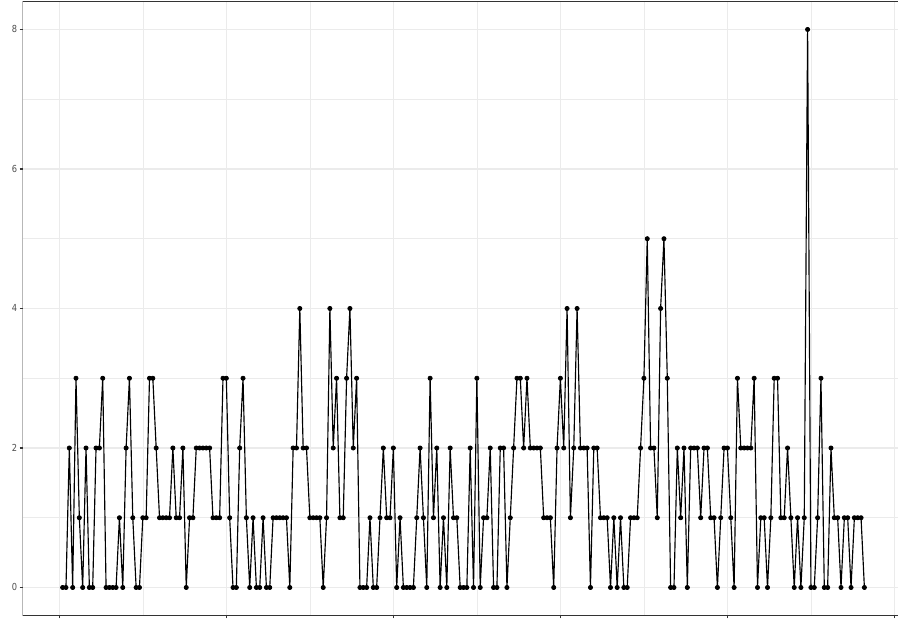
Figure 6. Time series of IP addresses.